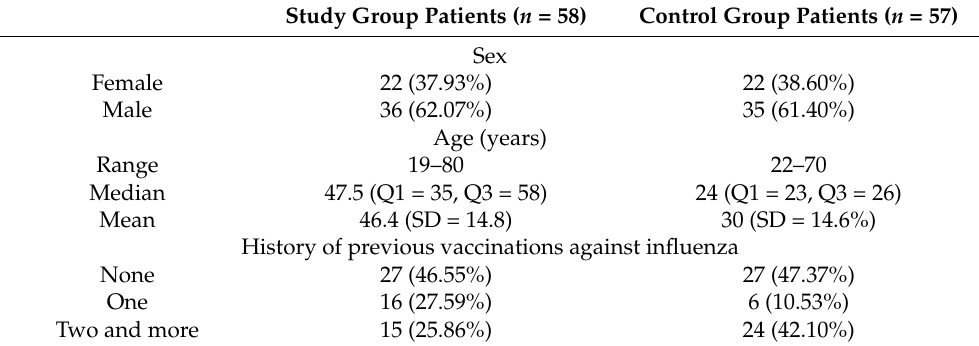
Table 1. Demographic data of the study group patients, total n = 58 (influenza seasons 2017/2018 and 2018/2019), and control group patients, total n = 57 (influenza seasons 2016/2017, 2017/2018, and